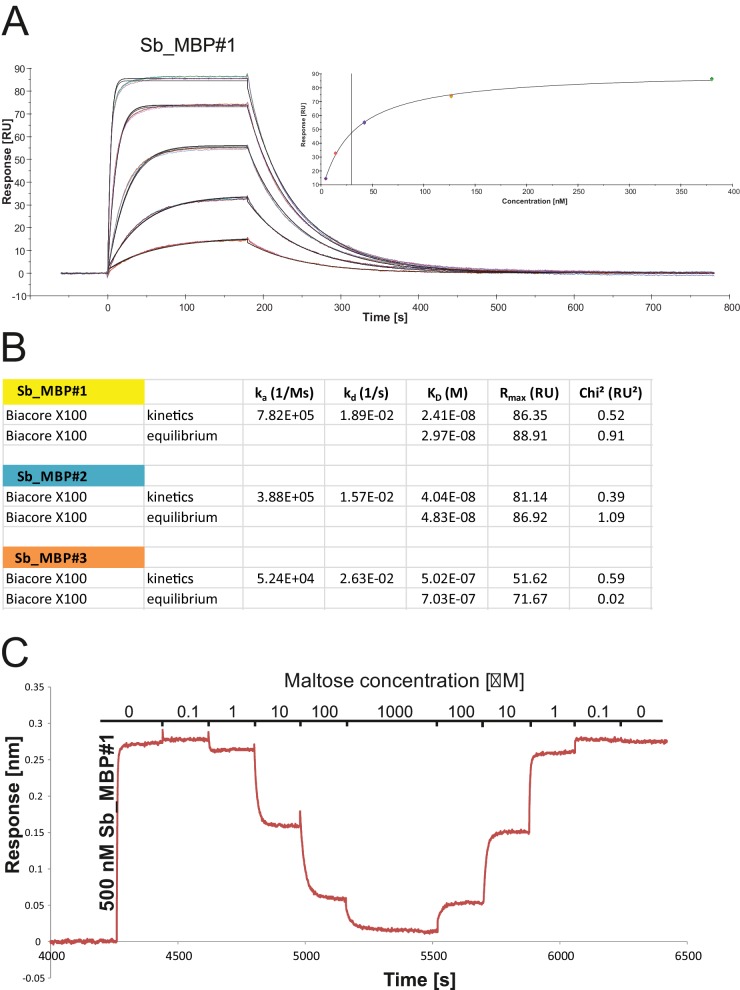
Biophysical analysis of sybody-MBP interactions.(A) SPR analysis of interaction between sybody Sb_MBP#1 (analyte) and biotinylated MBP (ligand), determined as technical triplicates for each analyte concentration. Concentrations of Sb_MBP#1: 0, 4.7, 14.1, 42.2, 126.7, 380 nM. Data were fitted with a 1:1 binding model to obtain kon, koff and KD, kinetics. Inset shows binding equilibrium data to determine KD, equilibrium. Sybodies Sb_MBP#2 and Sb_MBP#3 were analyzed accordingly. (B) Data table summarizing the values obtained from SPR analysis shown in (A). (C) Displacement of 500 nM Sb_MBP#1 bound to immobilized MBP by addition of increasing maltose concentrations was monitored using the Octet RED96 System.